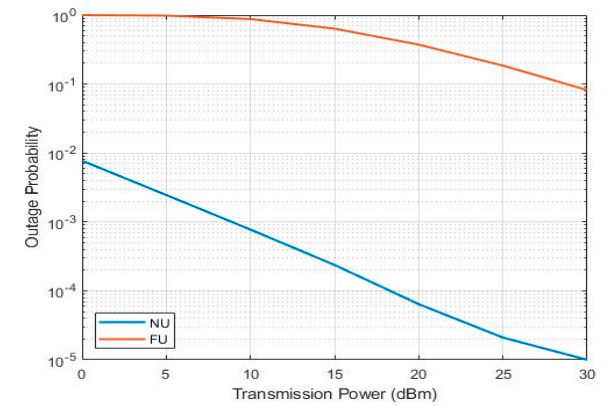
Figure 8. Outage probability vs. transmit power.